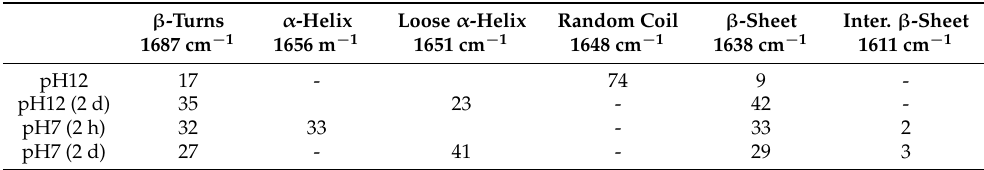
Table 1. Secondary structure of BSA–Au conjugate system in H 2 O estimated by the deconvolution of amide I IR band (expressed in %, the peak position of the component bands is provided). β -Turns 1687 cm − 1